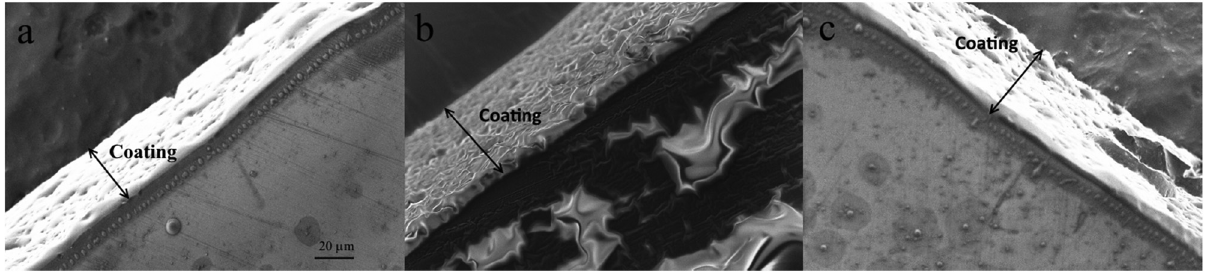
Figure 5: The cross - sectional views of AISI 316L coated with PU – PDMS polymers: ( a ) PU75 – PDMS25, ( b ) PU50 – PDMS50, and ( c ) PU25 –